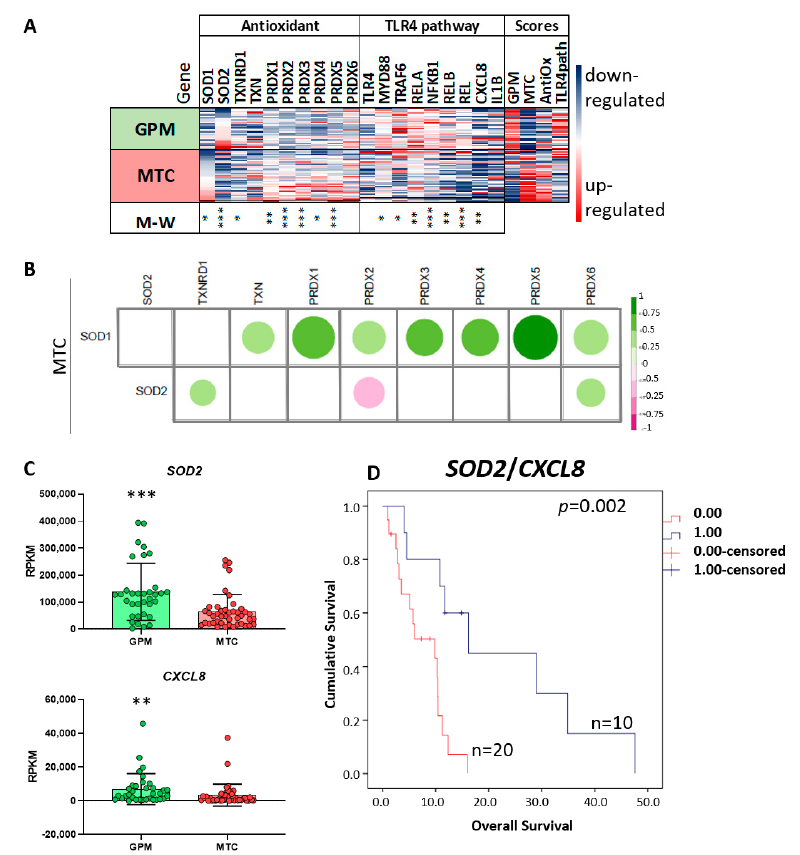
Figure 7. In silico validation of antioxidant and TLR4 pathway-related gene expressions in TCGA GBM-RNASeq dataset. ( A ) Heatmap of antioxidant and TLR4 pathway-related gene expressions normalized by z − score in 34 GPM and 43 MTC GBM subtypes according to Garofano’s classification. The gene signatures for each case were calculated, and a score value was designated and normalized by z − score. (*) p < 0.05, (**) p < 0.01 (***), p < 0.001 (Mann − Whitney test); ( B ) in MTC, Spearman’s correlation analysis showed strong correlation between the expression of SOD1 and other antioxidant genes. The size of the circles is proportional to the p values, and positive (green) and negative (pink) correlations are presented according to the rho values in the bar scale at right. ( C ) RPKM values of SOD2 and CXCL8 for GPM − and MTC − GBM subtypes, graph bar presenting the mean values. Each circle represents a GBM case. (**) p < 0.01 (***), p < 0.001 (Mann − Whitney test); ( D ) in GPM, longer OS was presented by GBM cases with higher SOD2 / CXCL8 ratio in a Kaplan − Meier graph, p = 0.002 by log rank test (four cases were censored).